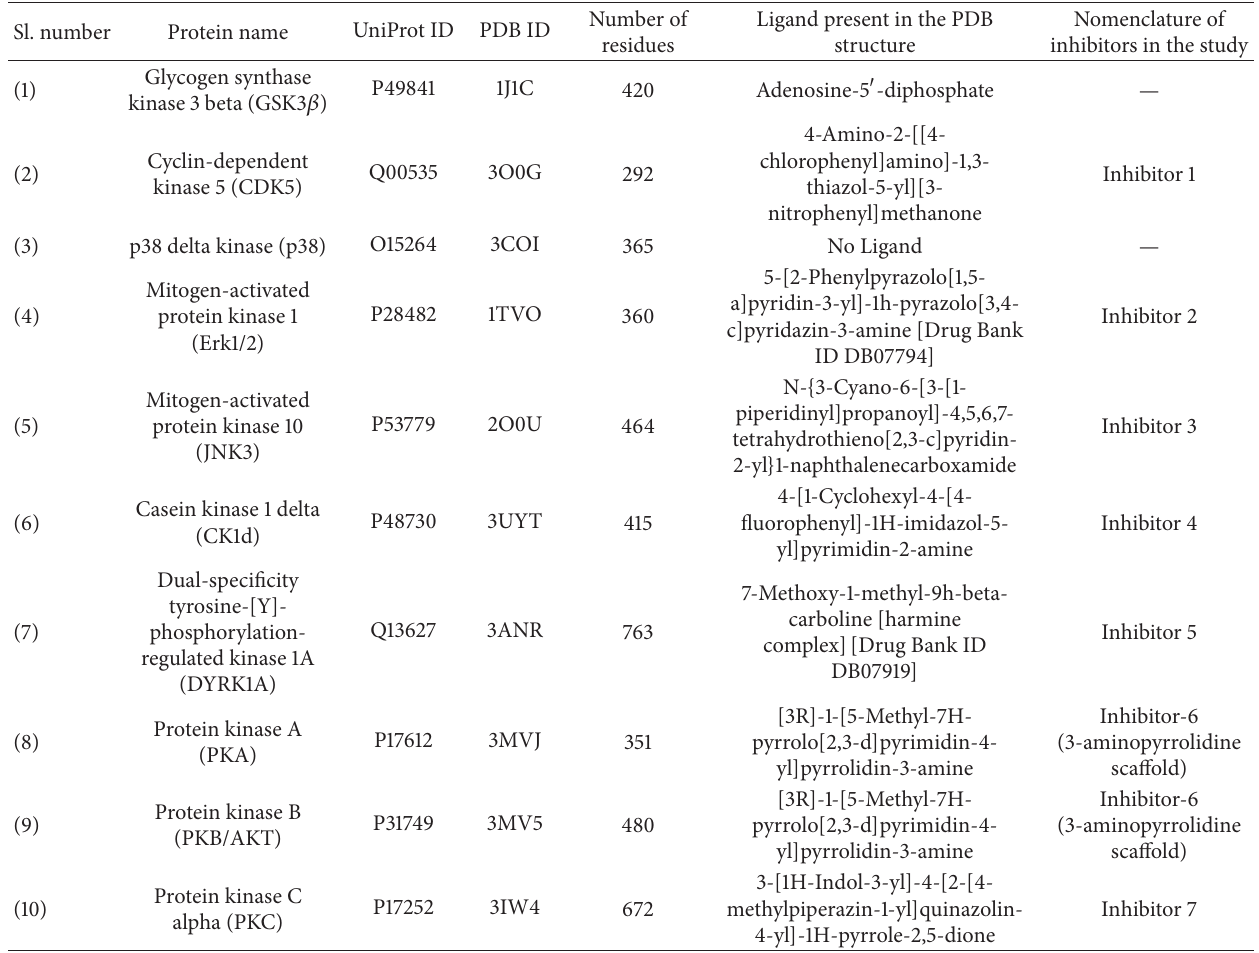
Table 1: Details of 10tau kinases used in the analysis.